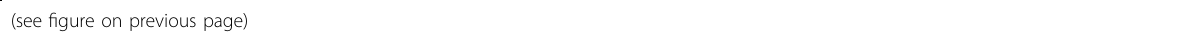
Fig. 5 Glucocorticoid treatment attenuates cell proliferation by elevating IFN signaling. a Proliferation scores 56 were estimated for all groups. b , c GSEA of type 1 interferon in C3 cells comparing UT to GCR ( b ) and GCR to GCNR ( c ) groups. d Beeswarm plot showing the expression of type 1 interferon in C3 among different groups. e Heatmap illustrating scaled expression of key genes in the type 1 interferon signaling pathway in C3 cells from the NC, UT, GCR and GCNR groups. f Heatmap showing scaled expression of cell cycle mediators in C3 of NC, UT, GCR and GCNR groups. g The expression of MYC in C3 is shown among groups. h The proliferation of RPS19- depleted, cord blood-derived erythroid cells treated with either IFN α or Dex alone, or their combination, assessed on day 4 of erythroid differentiation. Proliferation was normalized to the non-treated control cells. i Time course growth curves of patient-derived BM-CD34 + cells during erythroid differentiation, cultured either with Dex or IFN α alone, or their combination. Due to the limited cells available from the patients, we occasionally combined the patient samples together. j Representative FACS plots of CFSE staining in GCR patient-derived BM-CD34 + cells cultured either with Dex or IFN α alone or in their combination on day 8 of erythroid differentiation. k Quanti fi cation of ( j ). The MFI of each group of cells was normalized to that of non-treated control cells. For ( h and k ), the error bars represent the SEM and P values were determined using Student ’ s t tests. *** P < 0.001; ** P < 0.01 and * P < 0.05. n = 3 biological replicates. For the beeswarm plots ( a , d and g ), each dot represents the expression value that was calculated by summing the log 2 transformed UMI of every gene within the gene set of a single cell. Diamonds represent mean expression values for each cluster, and boxes represent the median and quartiles. P values were determined using Wilcoxon rank sum tests. **** P ≤ 0.0001, *** P ≤ 0.001 and * P ≤ 0.05; ns, no signi fi cance. See also Supplementary Fig. S7 and Table